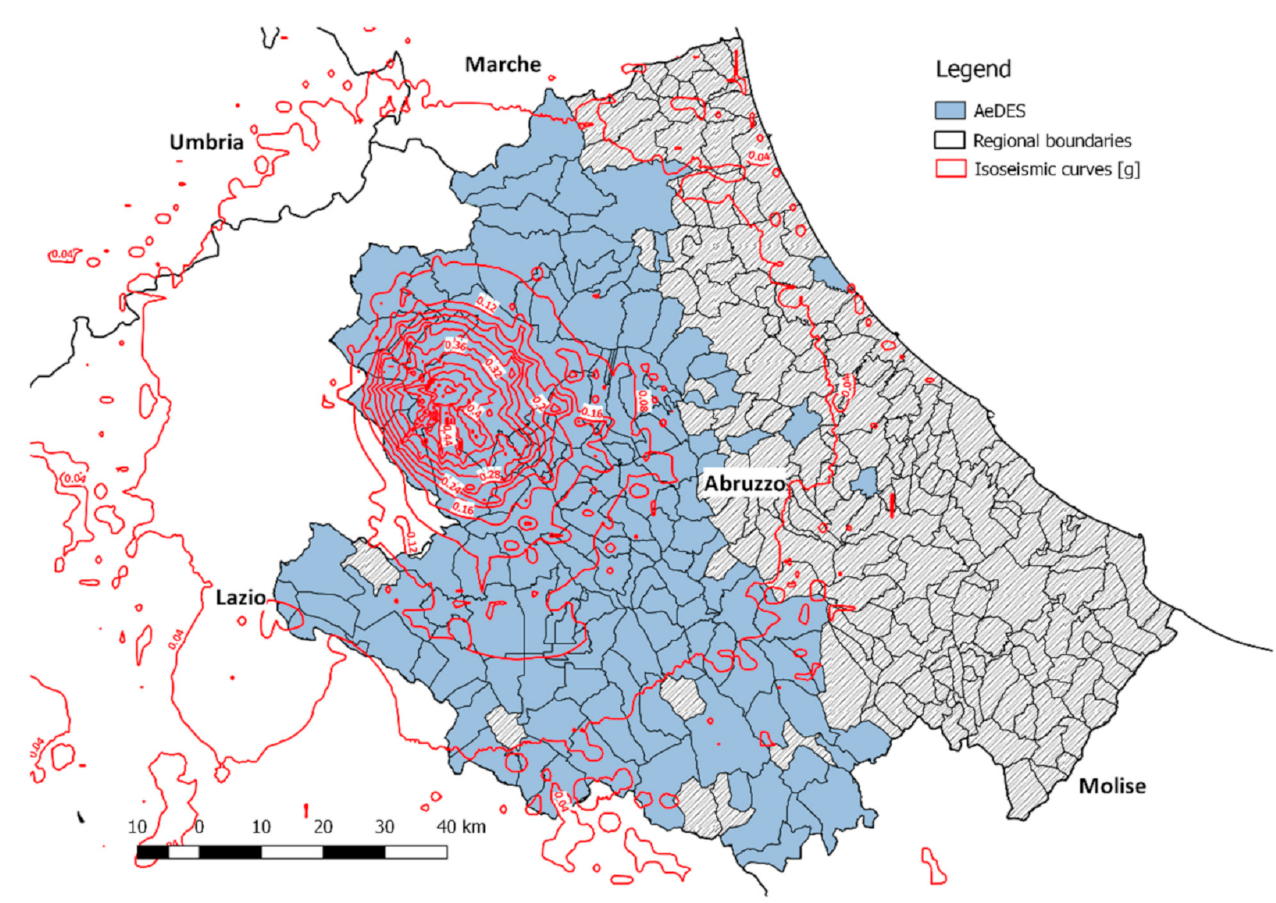
Figure 1. Abruzzo municipality boundaries and AeDES database coverage, superimposed on PGA shakemap. (Shakemap base from http://shakemap.rm.ingv.it/shake/1895389/products.html, ac- cessed on 1 June